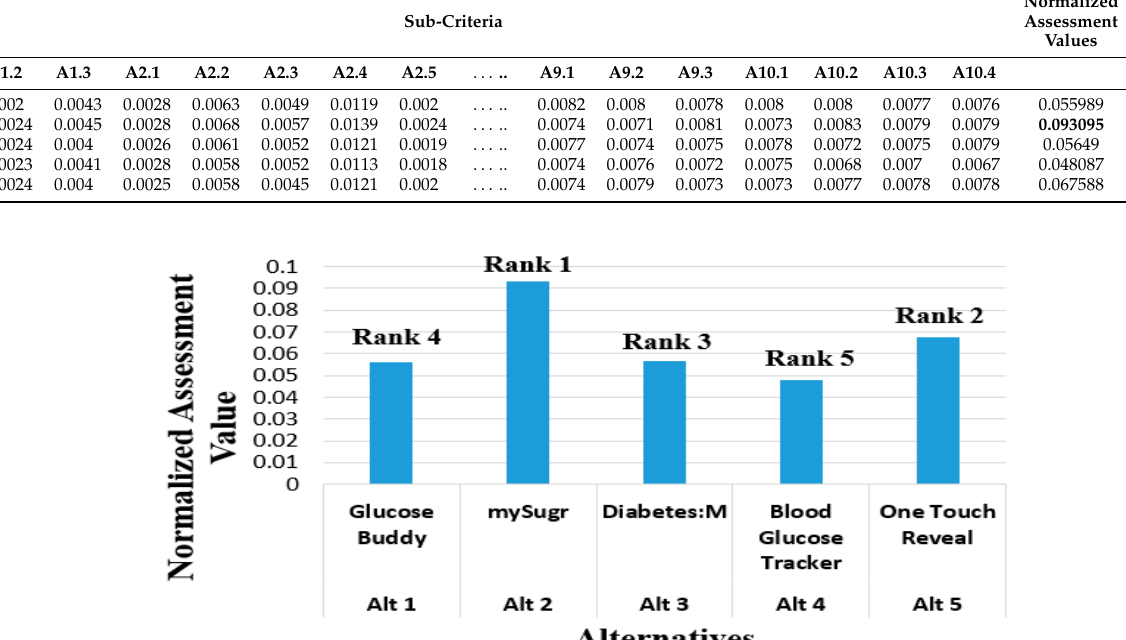
Figure 7. Rank obtained by MOORA based on normalized assessment value ( 𝑁𝐴 (cid:3036) ) .